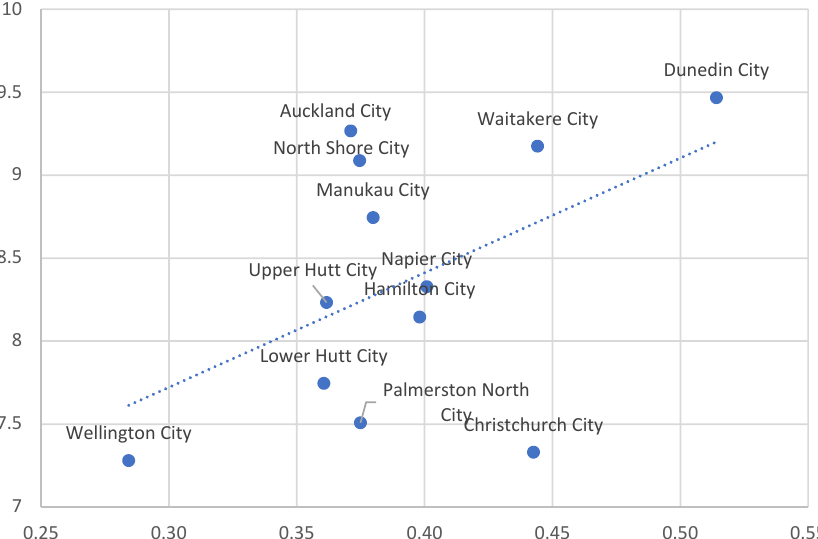
Figure 2. Beta-return relationships of the 12 City-TAs of New Zealand. Notes: This beta-return scatterplot is based on the single-factor CAPM model taking NZX50 as the market returns on the 12 City-TAs of New Zealand (excluding three outliers—Invercargill City, Porirua City, and Nelson City). The vertical axis represents the betas β T estimated in Model 1b of the TA, and the horizontal axis represents the average total return R t of the TA housing market. The best fit line R t = 6.91 β T + 5.65 achieves an R-squared of